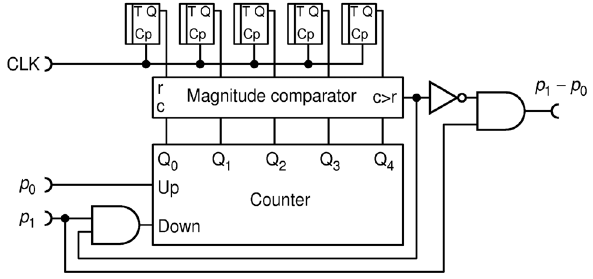
Figure 17. Subtraction circuit SUB2 with an improved output randomness.